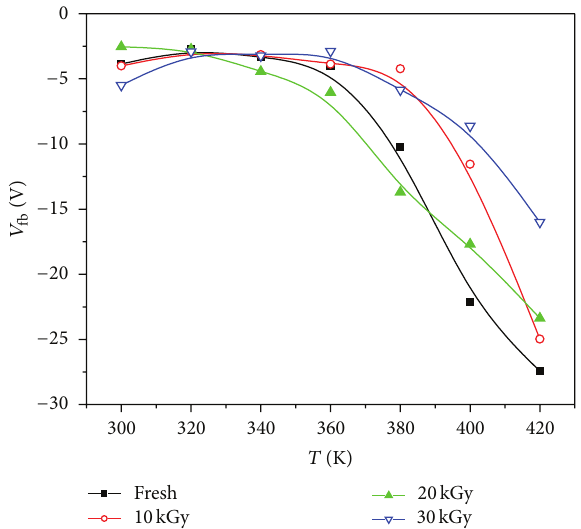
Figure 7: Temperature dependence of flat potential for the inves- tigated CdS/Si heterojunction before and after 𝛾 -irradiation with different